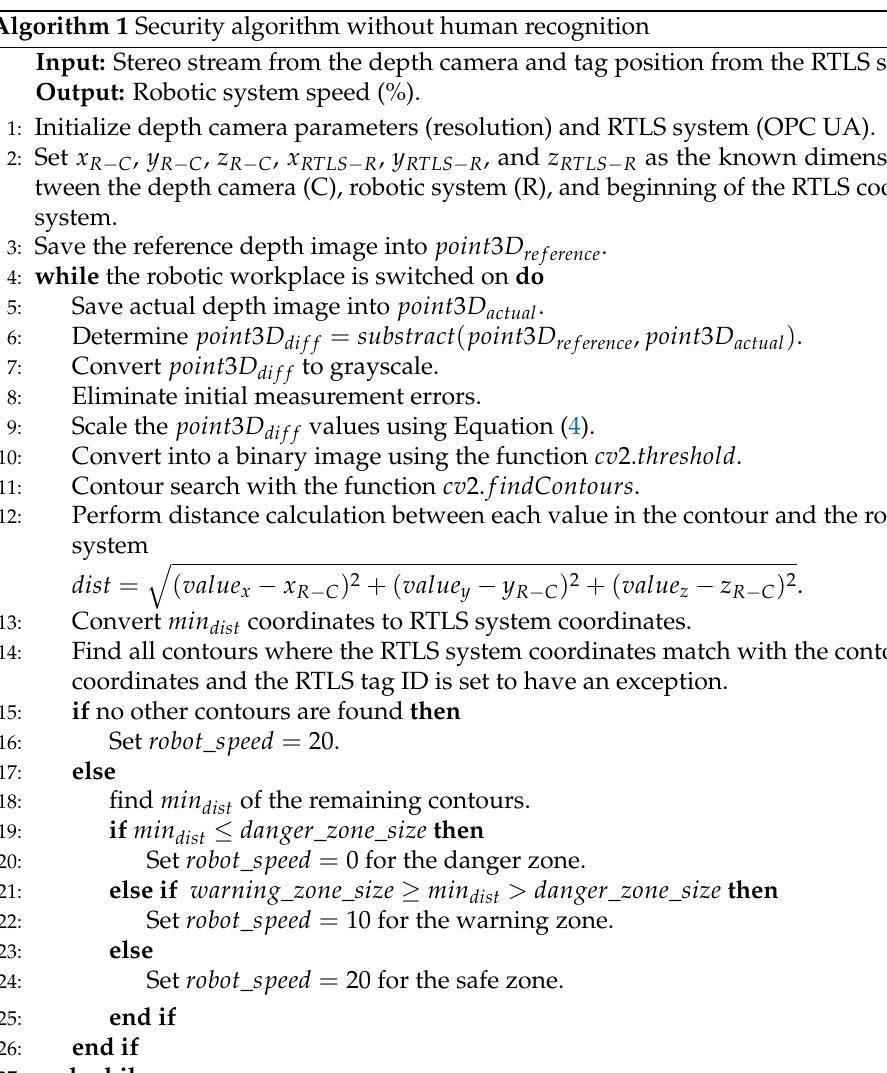
Algorithm 1 Security algorithm without human